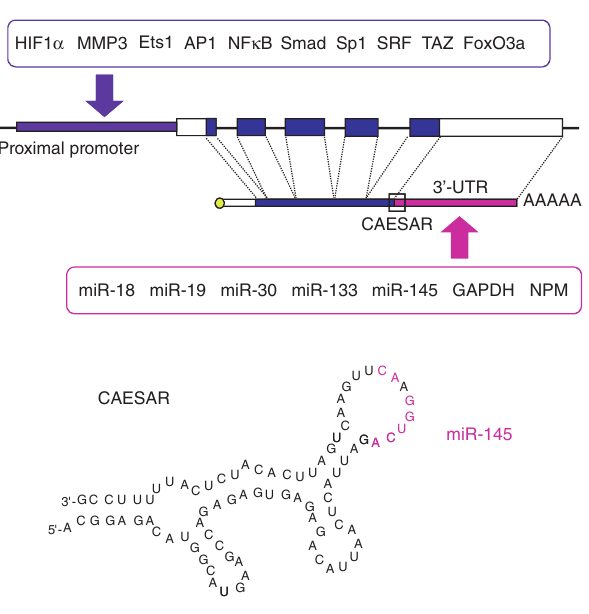
Figure 3 Transcription and posttranscriptional factors regulating the CCN2